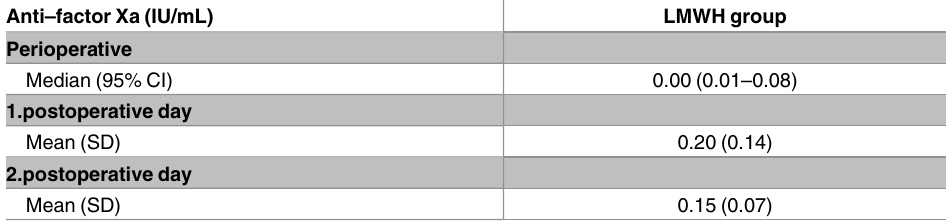
Table 6. Anti-factor Xa data from 32 patients planned for Video-Assisted Thoracoscopic Surgery (VATS) lobectomy for primary lung cancer and randomized to receiveLow-Molecular-Weight Heparin (LMWH).